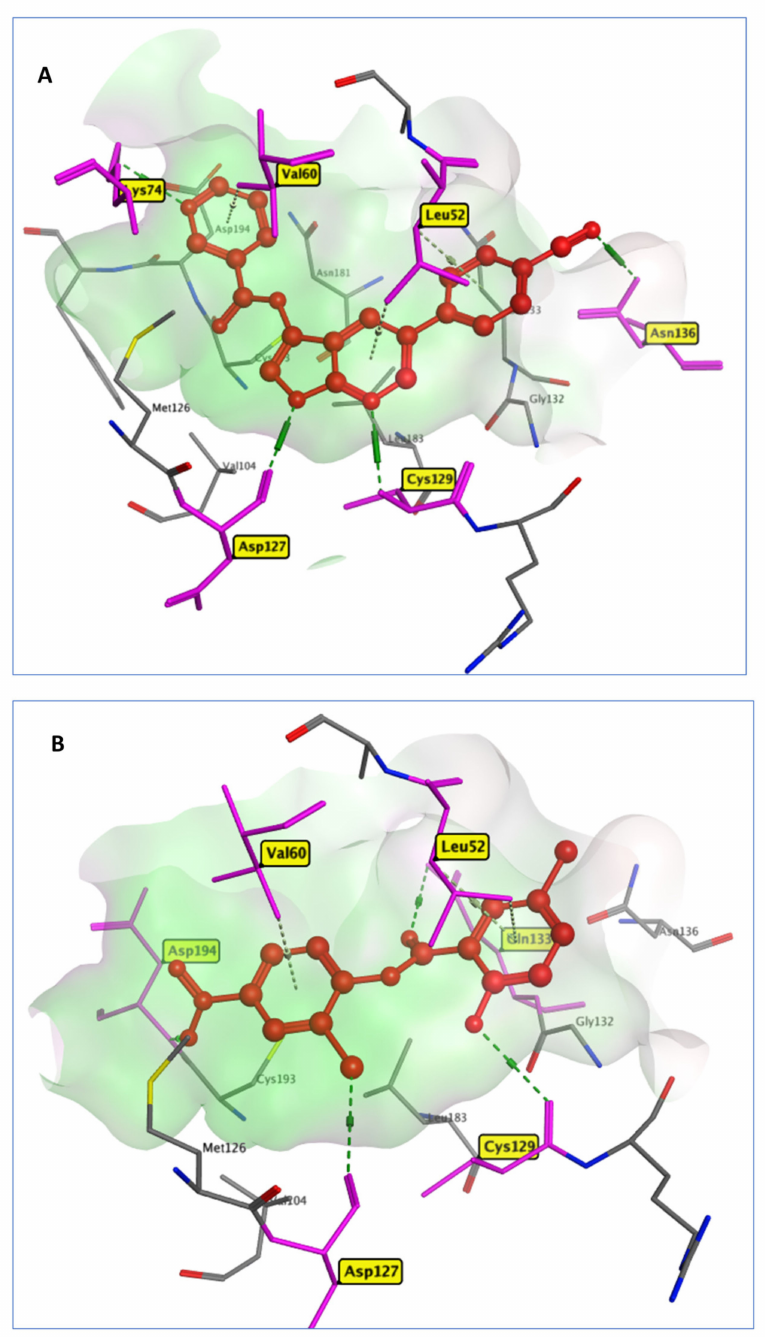
Figure 7. 3D model of the interactions between crystallized ligand LKB ( A ) and NIS ( B ) in 5L4Q active site